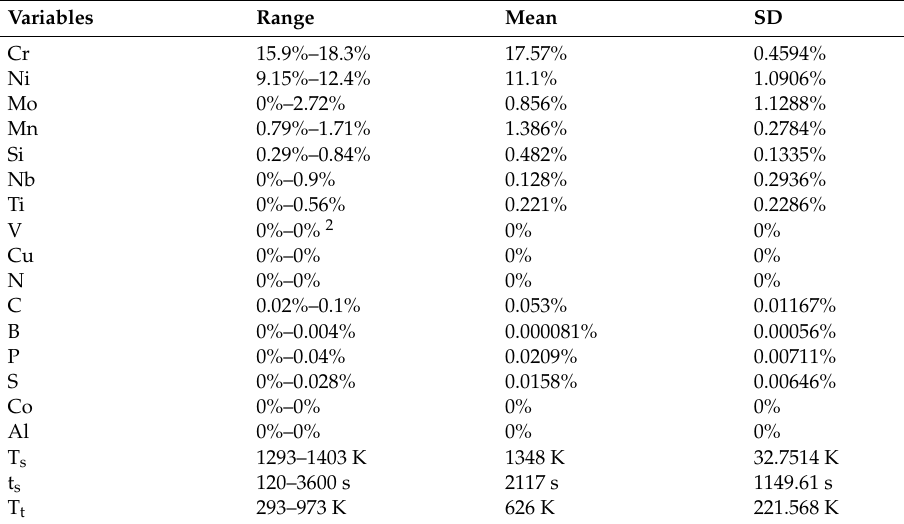
Table A2. 394 samples with air quenching after solution treatment (label: